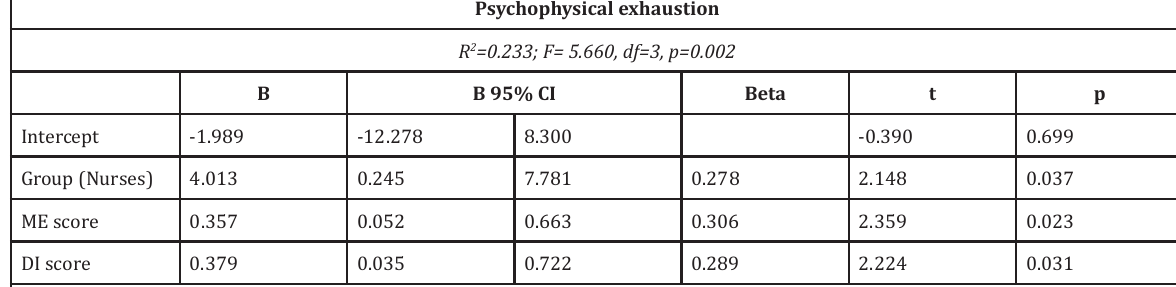
Table 3. Parameters of linear regression models for the prediction of the Link Burnout Questionnaire (LBQ) dimensions in the studied